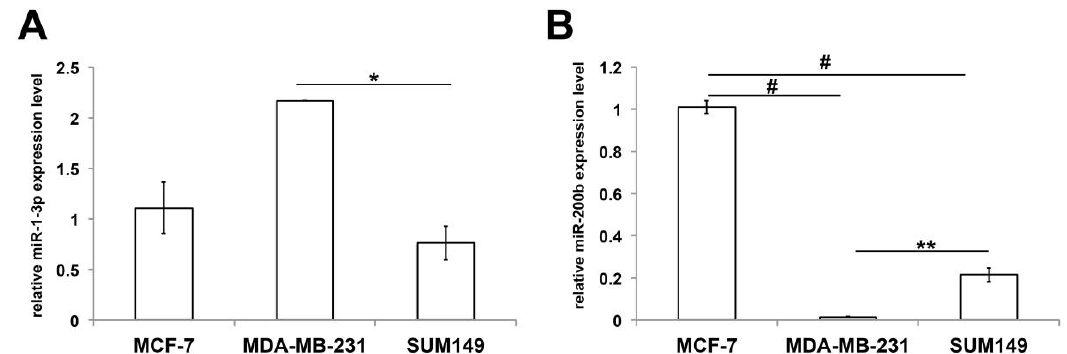
Figure 7. Expression levels of miR-1-3p and miR-200b in the non-IBC (MCF-7 and MDA-MB-231) and the IBC (SUM149) cells. qPCR was used to quantify the expression levels of miR-1-3p ( A ) and miR-200b ( B ) in different human breast cancer cell lines. Data represent the mean ± SEM, n = 3. * p < 0.05, ** p < 0.01, and # p < 0.001 as determined by Student’s t -test.